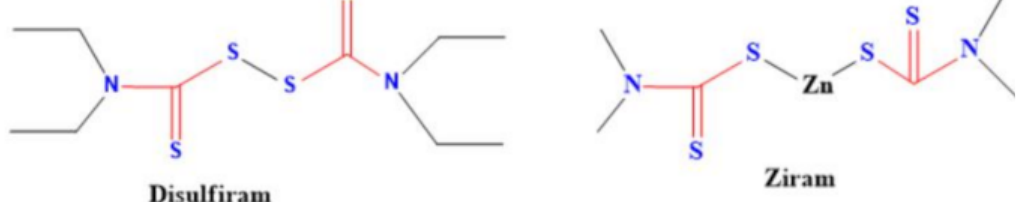
Figure 9. Representative of dithiocarbamate compounds used for the treatment of diseases. Dithiocarbamate drugs (Propineb, Zineb and Maneb) were also found to be useful